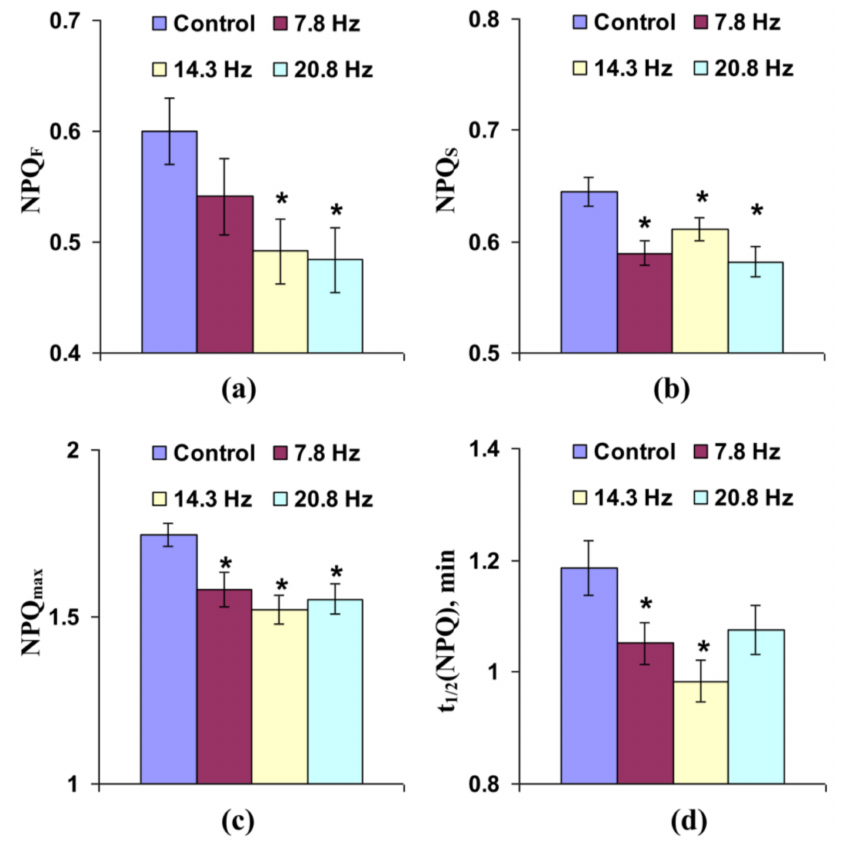
Figure 4. Influence of short-term treatment by artificial extremely low frequency magnetic field on the fast-relaxing component of non-photochemical quenching under illumination (NPQ F ) ( a